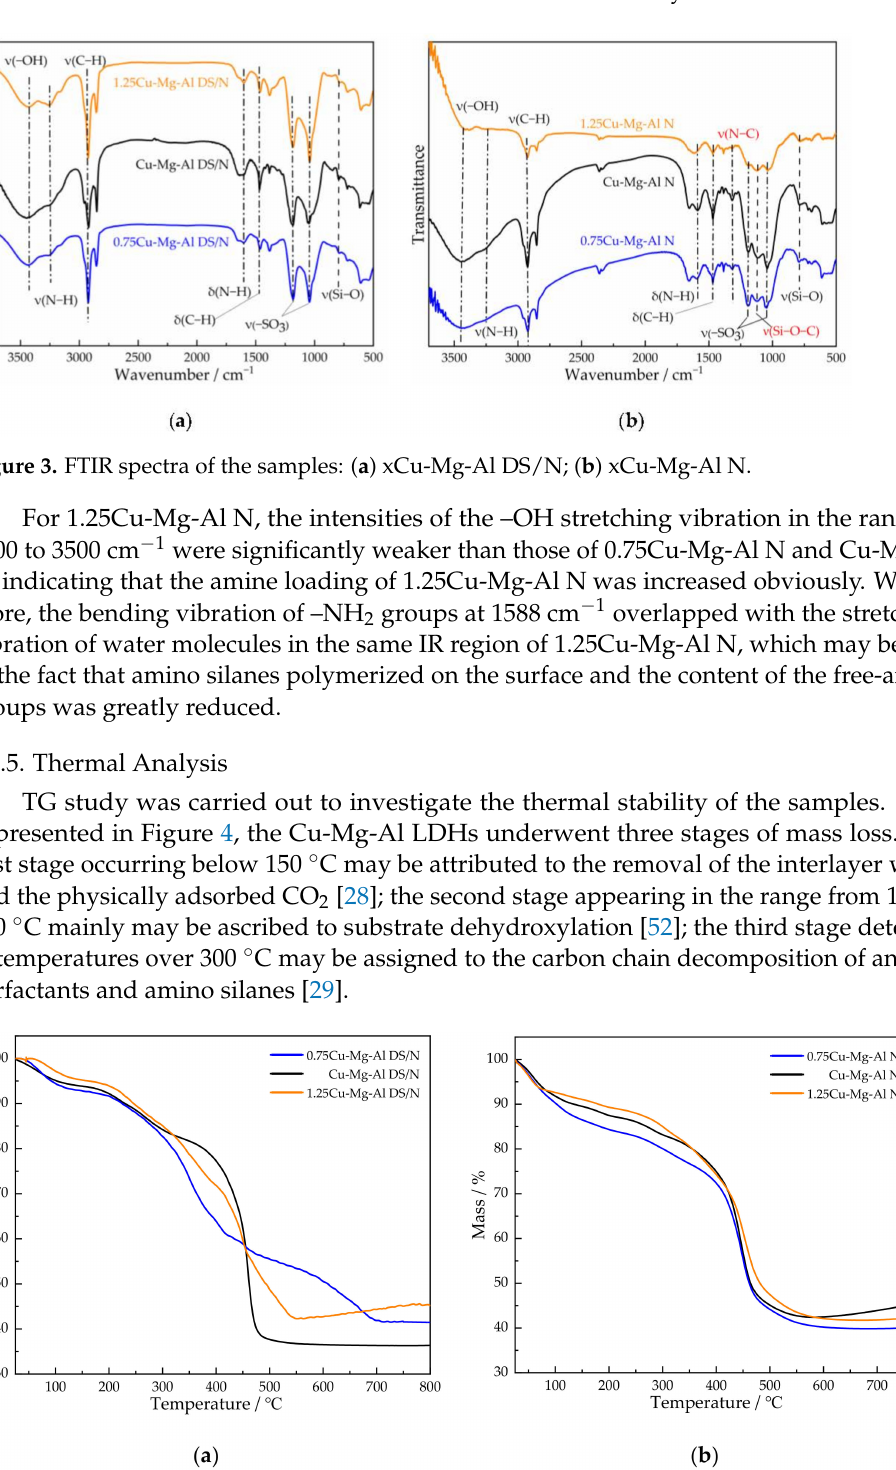
Figure 4. Thermogravimetric (TG) curves of the samples: ( a ) xCu-Mg-Al DS/N; ( b ) xCu-Mg-Al